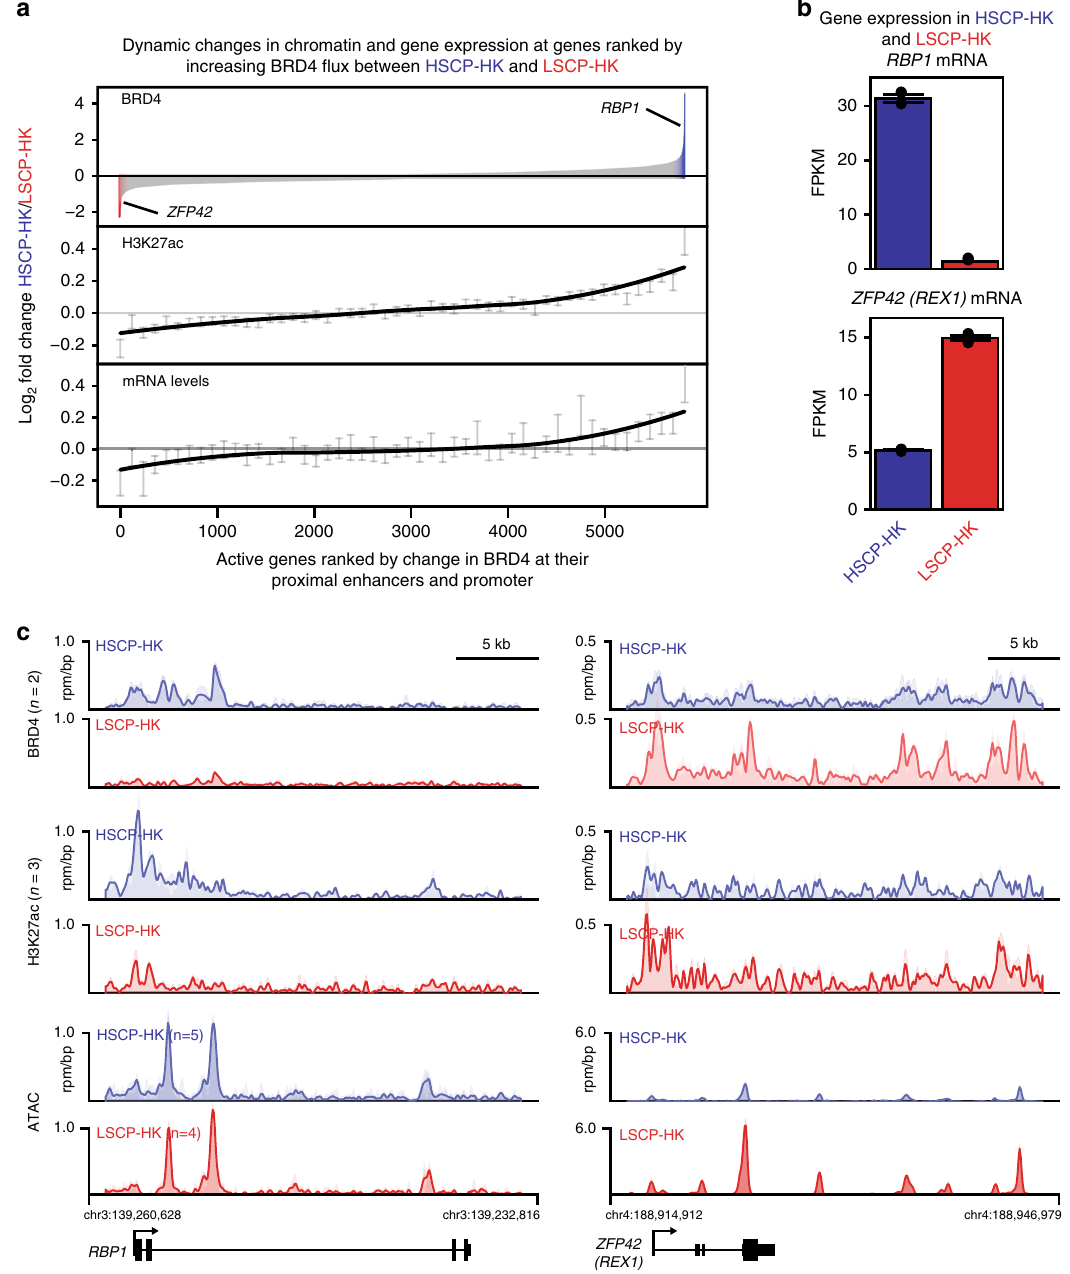
Fig. 2 Dynamic redistribution of BRD4 between HSCP-HKs and LSCP-HKs. a Ranking of all active genes by change in BRD4 occupancy at their promoter and proximal enhancers between HSCP-HK and LCSP-HK, with fold change in BRD4 occupancy shown in top panel. In middle and bottom panels, fold change in H3K27ac and mRNA levels are shown using a binned average (100 genes per bin), respectively. Error bars represent 95% con fi dence intervals (CI) of the average as determined by resampling with replacement (1000 permutations). A trend line (black) is overlaid by lowest locally weighted regression. b Transcript levels of RBP1 and ZFP42 based on RNA-seq (FPKM) comparing HSCP-HK to LSCP-HK. Error bars represent standard deviation. c Chromatin occupancy of BRD4 and H3K27ac (ChIP-seq) as well as chromatin accessibility (ATAC-seq) at RBP1 and ZFP42 genomic loci as read density in units of reads per million per base pair (rpm/bp). Individual HSCP-HK (blue) and LSCP-HK (red) replicates are shown as shaded traces. The average of replicates is drawn as a solid “ drop-out ” of HSCP-HK TFs (MYC, E2F4, MAZ, TEAD1, and NFE2L2), indicative of a role in maintaining stem cell function (Fig. 4b). E2F4 and MYC, within the top three CRC candidates, are known positive regulators of keratinocyte proliferation 45,46 (Fig. 3d). MYC was amongst the top TFs whose editing drastically reduced cell proliferation (from day 12 to day 28) whereas a “ neutral ” CRC TF, SNAI2, was shown to be among the top TFs